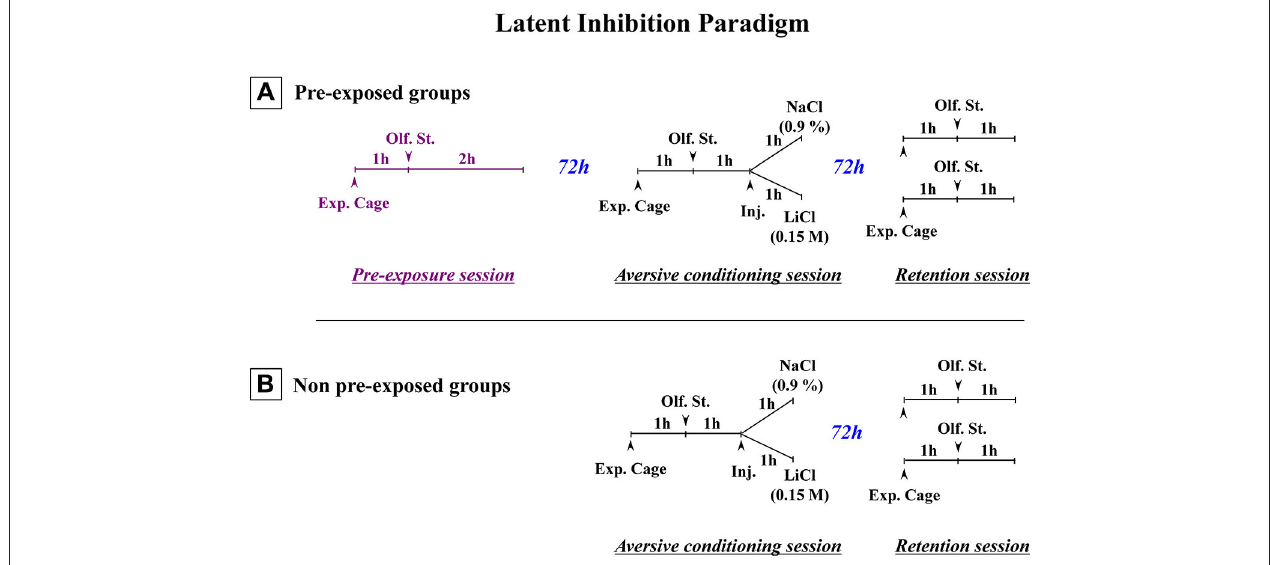
an isotonic solution of LiCl (0.15 M). They then remained in the cage with the olfactory stimulus for a further hour. 72 h later, they were returned to the experimental cage for the test (third) session. After a 1-h familiarization period, they were exposed to the CS for a further hour. Their attraction or aversion towards the olfactory stimulus (banana odor) was then assessed in terms of how much time they spent near the olfactive source. The olfactory aversive conditioning protocol (B) was exactly the same except that non-pre-exposed animals were subjected only to the conditioning (second) session and the test (third) session (Adapted from Jeanblanc et al.,